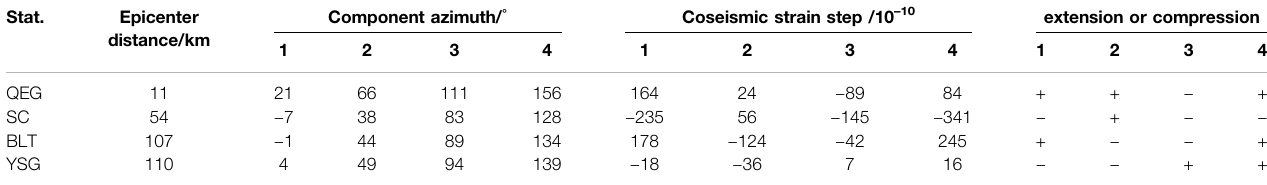
TABLE 2 | Observed coseismic strain step characteristics Stat.